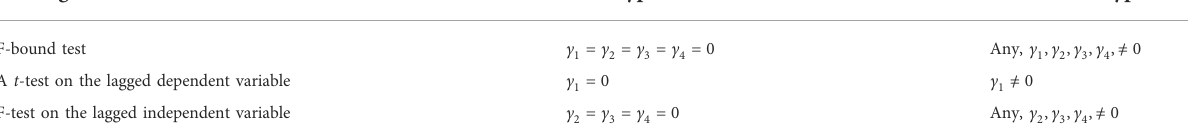
TABLE 2 Null hypotheses for all three tests are de fi ned as